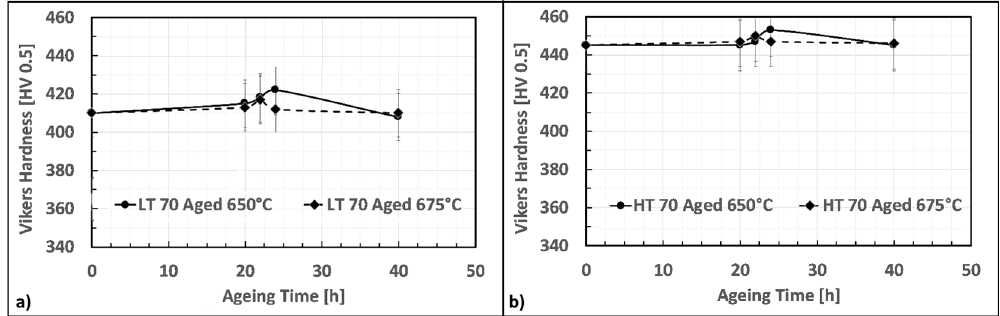
Figure 6. Second aging hardness curve for LT sample ( a ) and HT samples ( b ).